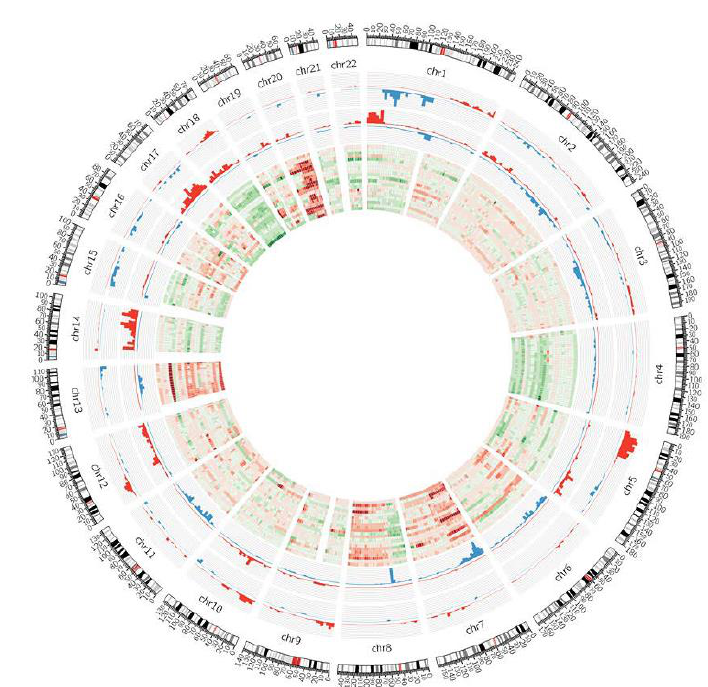
Figure 3. The circos plot of relapse hotspot regions in the CRCLM cohort. Outside to inside: synchronous metastasis (yes vs no); recurrence (yes vs no); copy number alteration in 21 CRCLM patients.